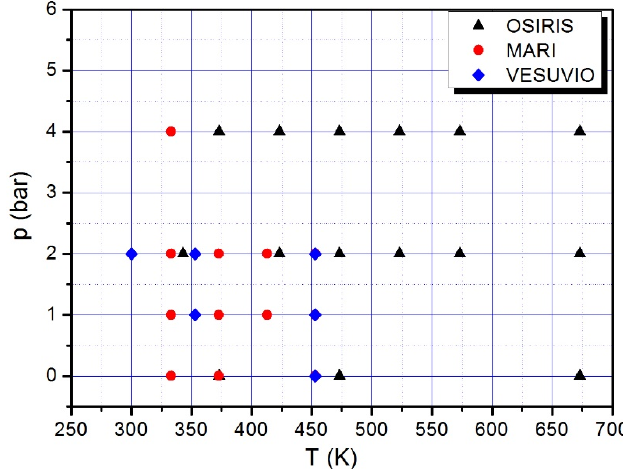
ff erent neutron scattering experiments. OSIRIS Figure 8. Pressures and temperatures selected for the different neutron scattering experiments. Figure 8. Pressures and temperatures selected for the di is for Quasi-Elastic Neutron Scattering (QENS) measurements, MARI for IINS, and VESUVIO for Neutron Transmission (NT) and Deep Inelastic Neutron Scattering